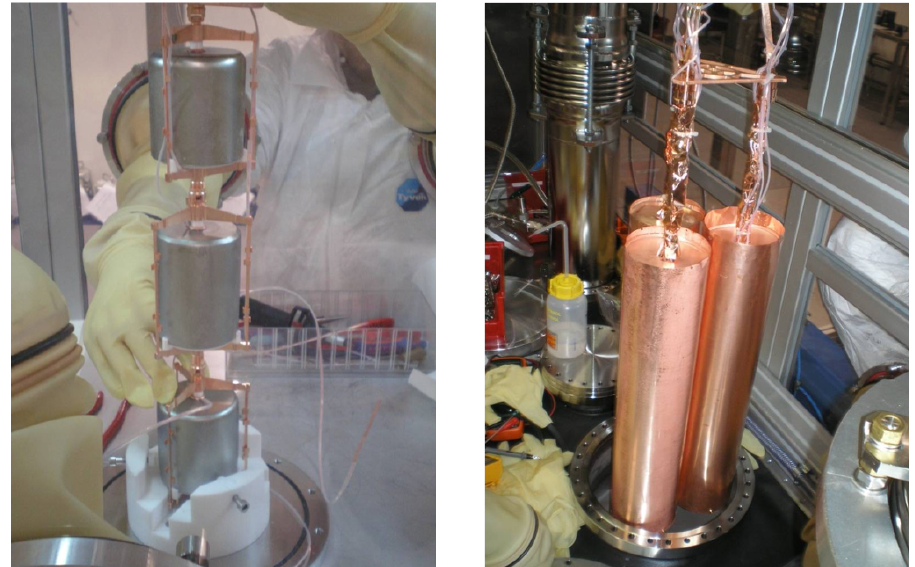
Figure 5. One naked Ge detector string ( left ) and the three Phase I strings enclosed in their Cu “mini-shrouds” while being inserted into the cryostat ( right